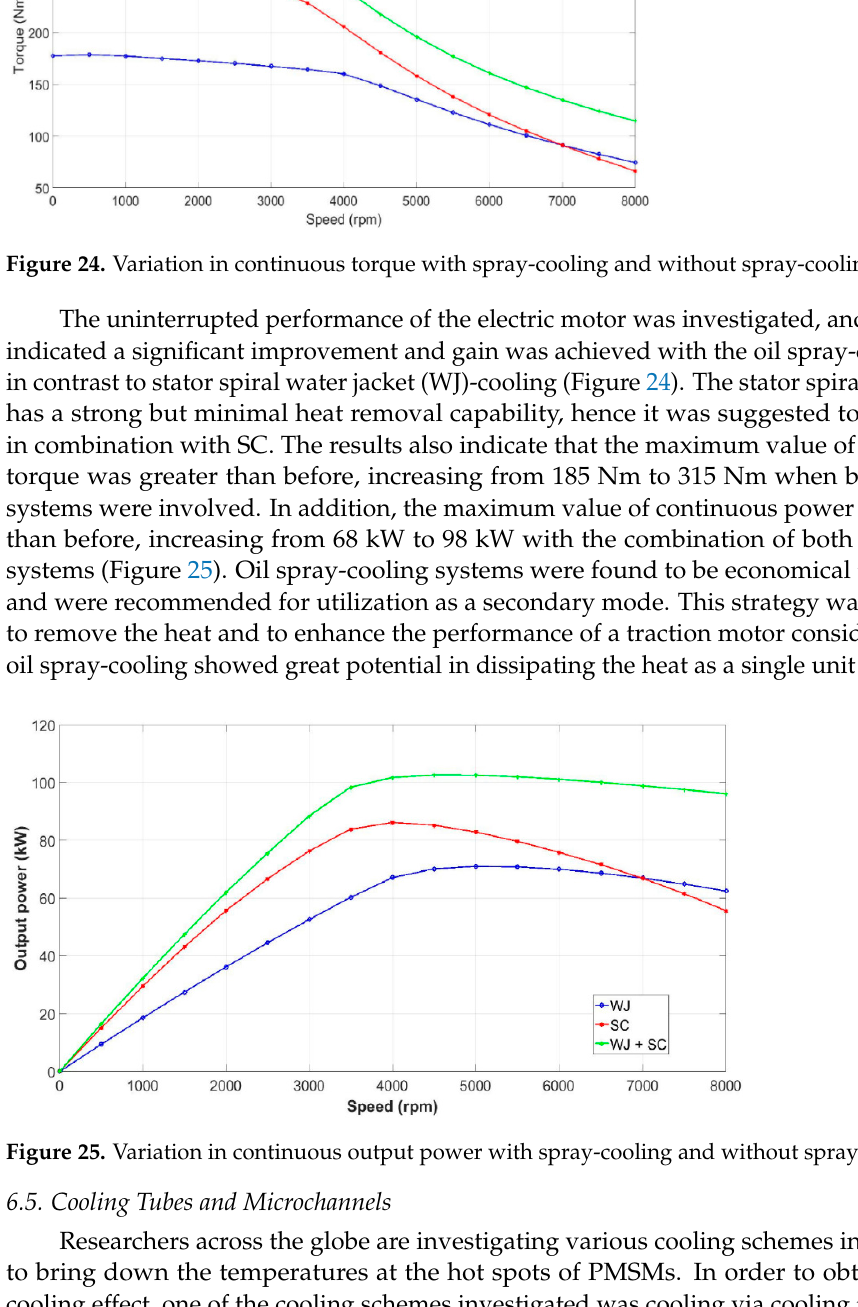
Figure 26. Structure of cooling tubes inside stator slots [68]. Figure 27. Stator cooling with micro channels [68].